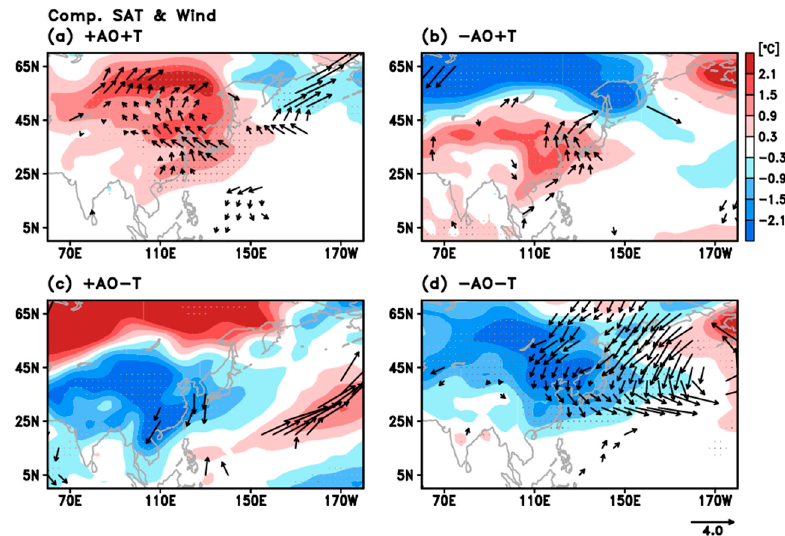
Figure 4. Same as Figure 3, but for SAT (shading) and wind anomalies at 850 hPa (vector). Light (dark) gray dots denote grid points which satisfy 90% (95%) confidence level through the two-tailed Student’s T-test. Wind vectors are marked only for the grids which satisfy 90% confidence level.